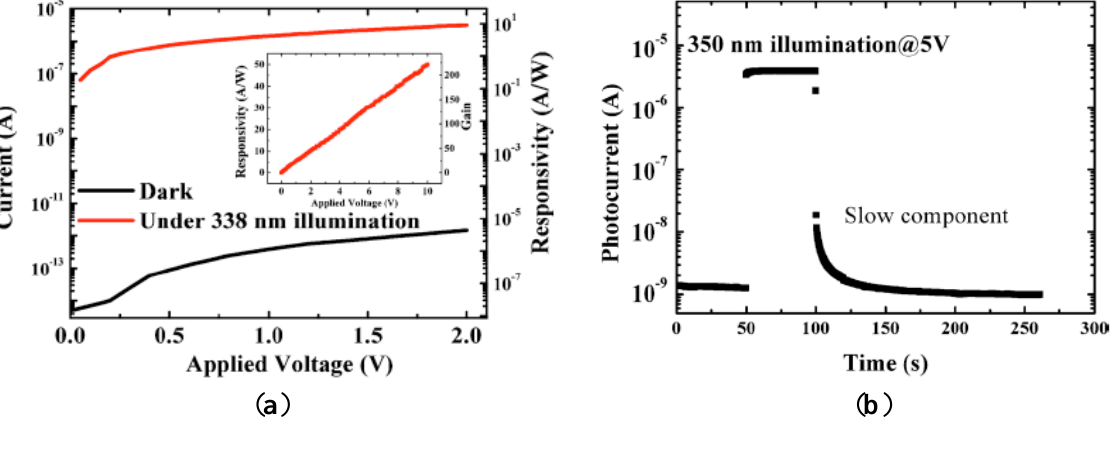
Figure 6. ( a ) I-V characteristics and responsivity in the dark and upon 338 nm light illumination. The inset shows the responsivity dependence on the applied voltage; ( b ) Time response upon 350 nm light illumination measured by a mechanical chopping